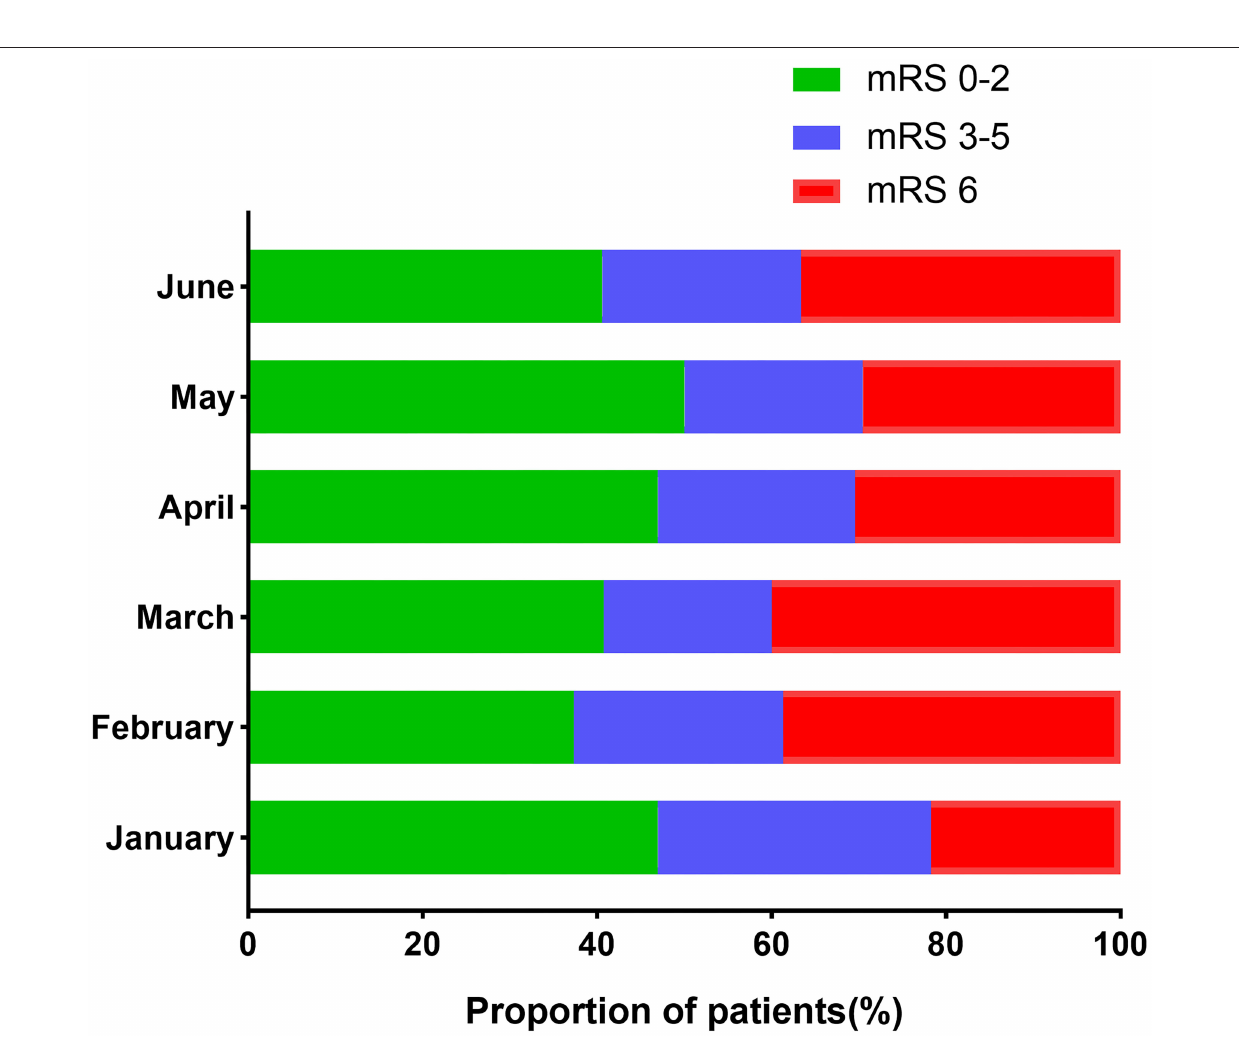
Frontiers in Neurology |